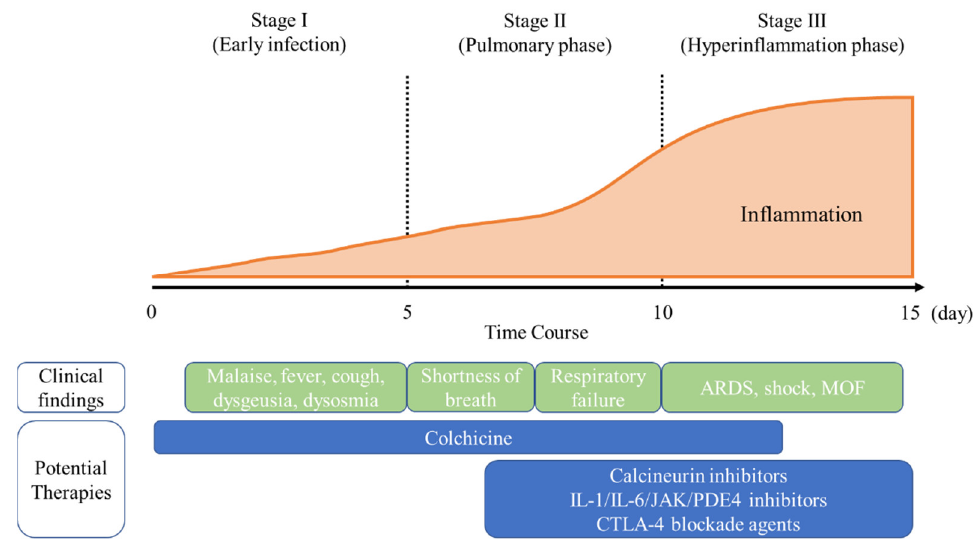
Figure 1. Classification of COVID-19 states and potential therapies. The figure illustrates the three escalating phases of COVID-19 progression with associated symptoms and potential phase-specific therapies. ARDS, acute respiratory distress syndrome; CTLA, cytotoxic T lymphocyte-associated antigen; IL, interleukin; JAK, Janus kinase; MOF, multiple organ failure; PDE,